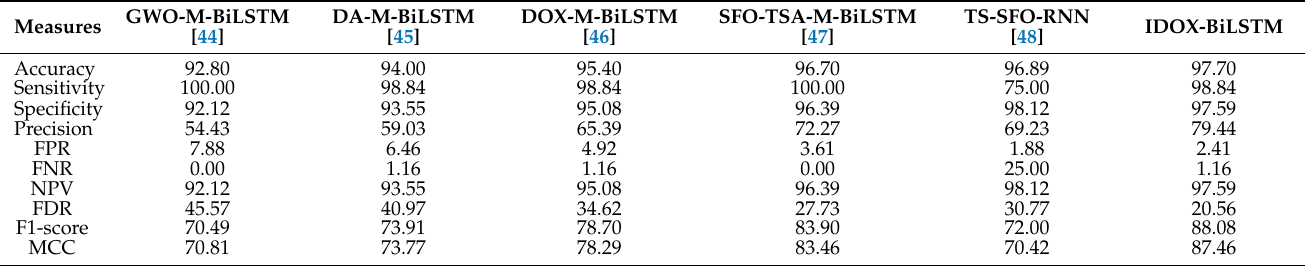
Table 3. Validation of the developed IDOX-based heart disease prediction model in WBAN with multiple